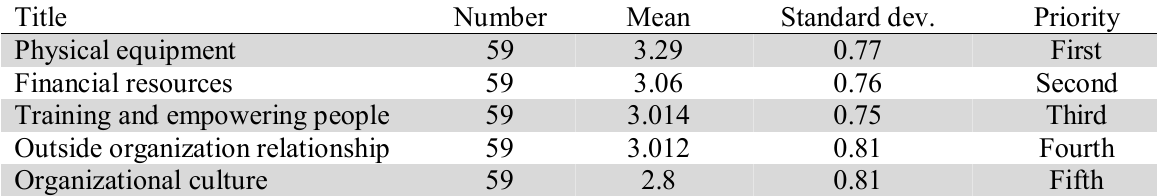
The summary of Freedman